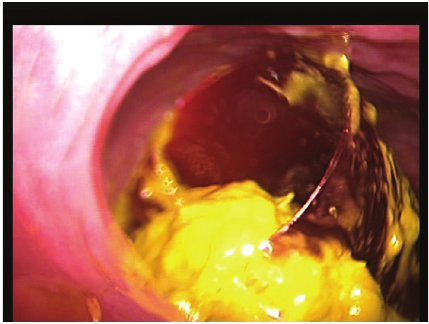
Figure 5: The instruments have been used to manipulate the cigar sheath and to overcome the vacuum effect. The dislodged cigar case has been rotated within the lumen so that the rim now faces the laparoscope.